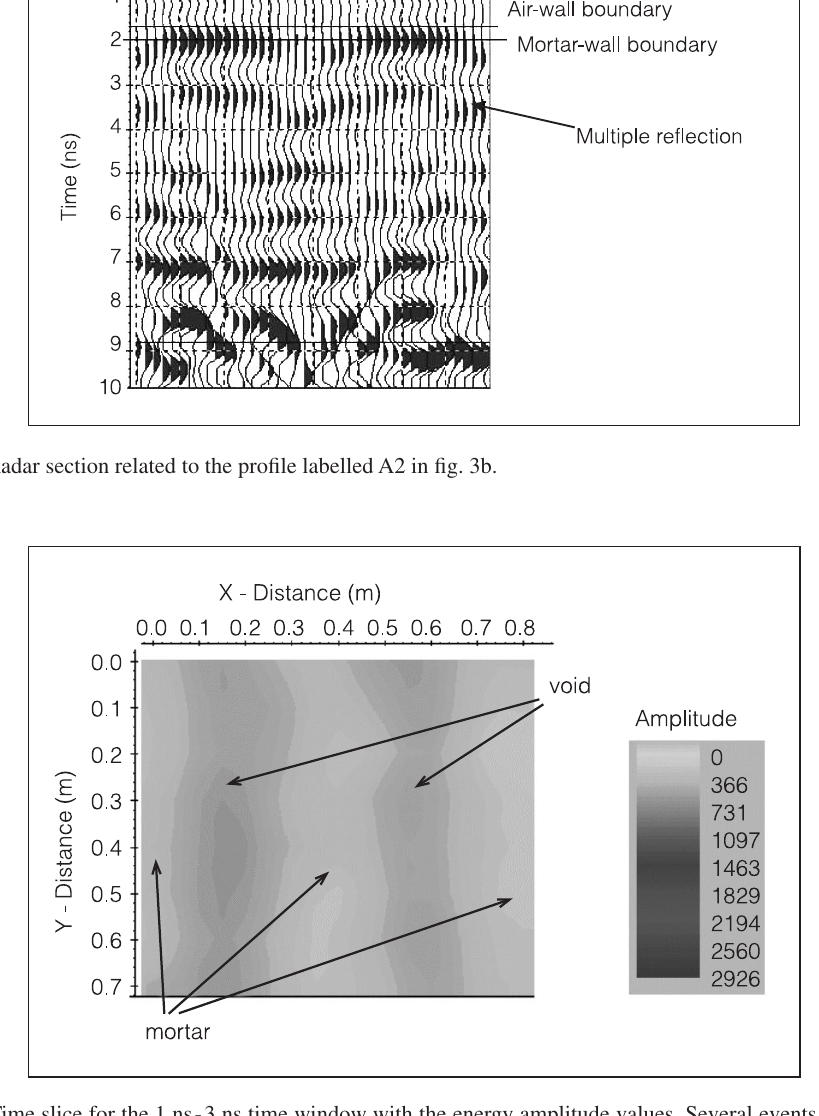
Fig. 5. Time slice for the 1 ns-3 ns time window with the energy amplitude values. Several events are visible as high amplitude anomalies (dark region) that coincide with the shape and position of the voids between the travertine panel and the wall. The weak amplitude anomalies (clear region) coincide with the shape and position of the mortar between the travertine panel and the